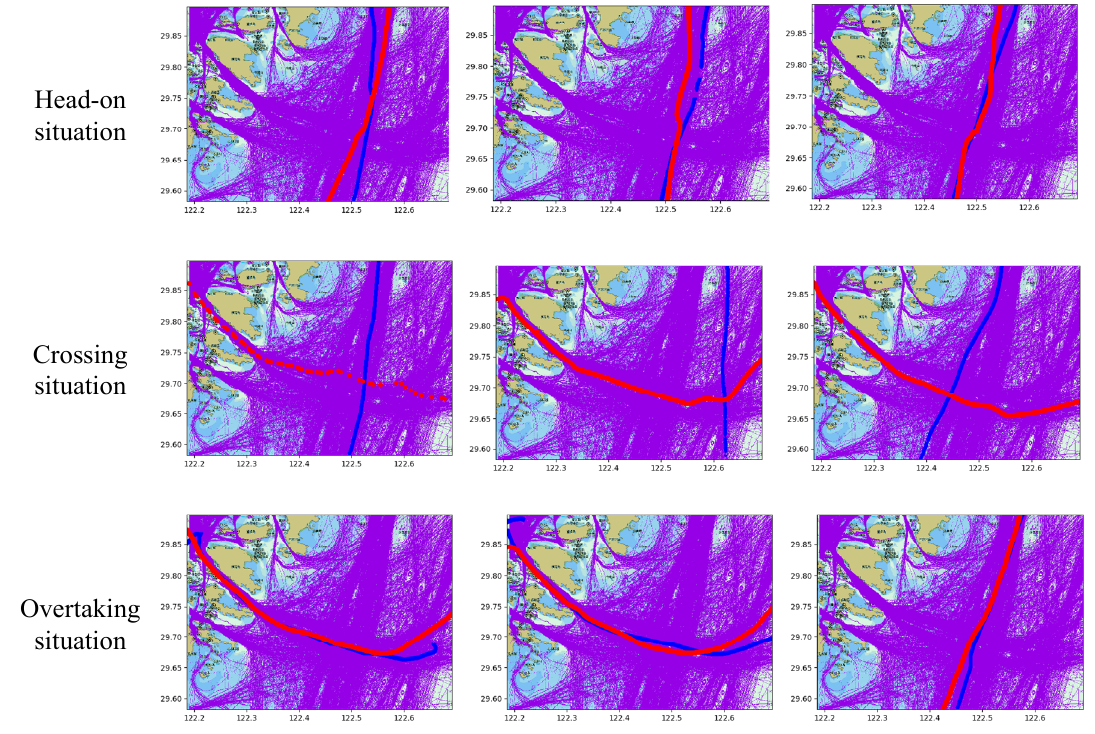
Figure 5. The AIS trajectory data in ship-encounter situations.